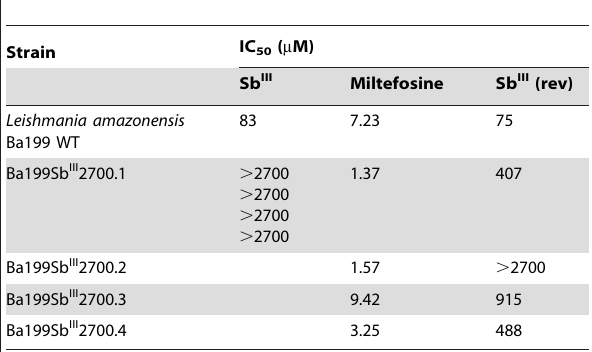
Table 1. Inhibitory concentration of L. amazonensis strain Ba199 antimony-sensitive and –resistant independent mutants.